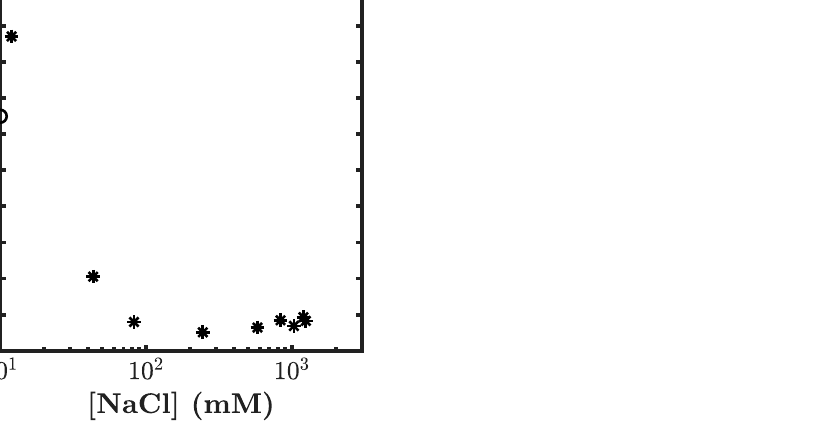
Figure 5. Swelling ratio of the P(AAm- co -VIm)-Na 2+ dual-crosslink gel with [Ni 2+ ] = 5 mM as a function of salt concentration [NaCl]. The open circle represents the swelling ratio of the chemical gel in distilled water (without NiCl 2 or NaCl).